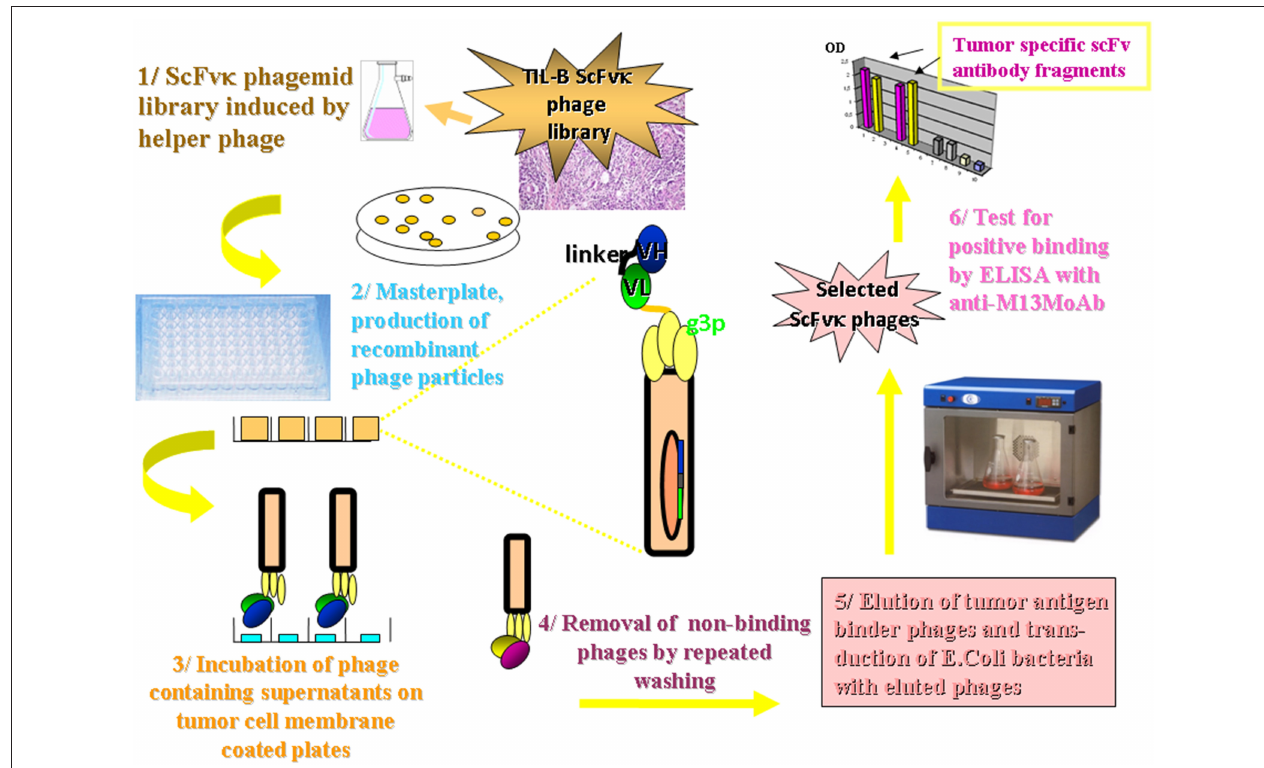
FIGURE 4 | Methodology flow chart on the selection of tumor binder scFv fragments by ELISA. The flow chart presents the new tumor infiltrating B cell antibody fragment phage display technology. It describes the biotechnological processes and our detection system. A master plate was prepared that enabled the detection of our scFvK phage display library in a soluble scFv and a phage displayed scFv form after rounds of panning reactions. Antibody fragments could be selected in the course of an ELISA using 95 well maxisorbe plates precoated with native cancer membrane preparations.